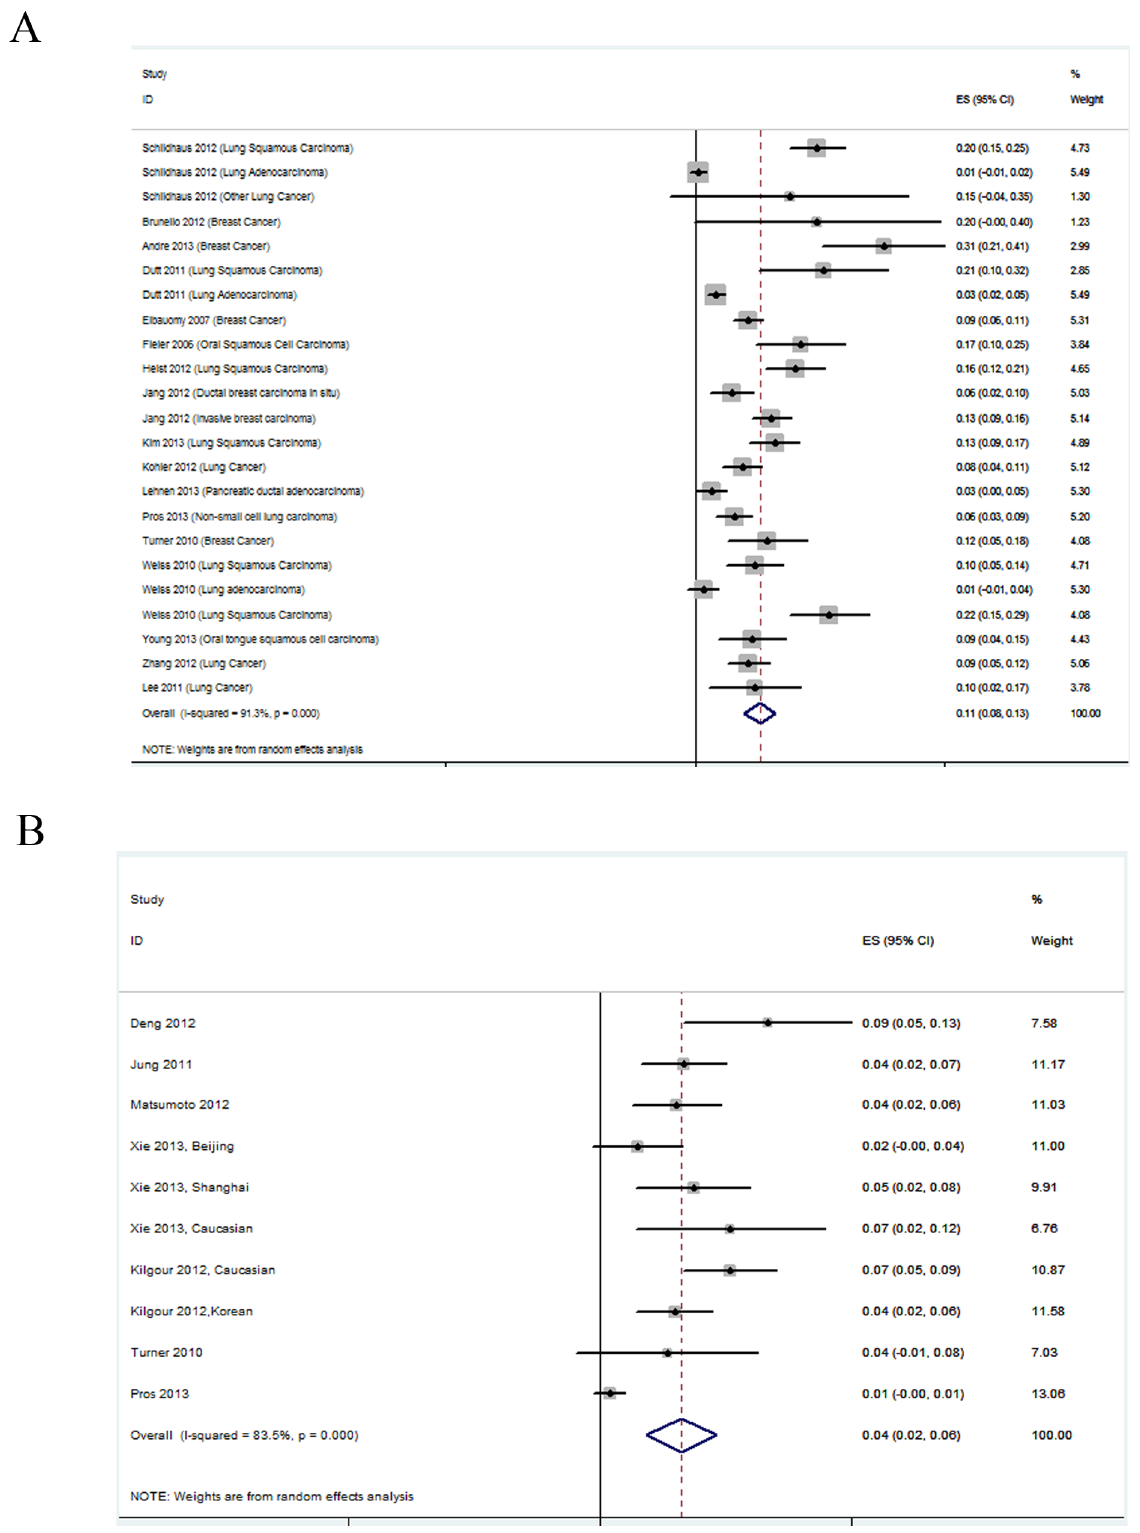
Figure 2. Forest plots describing the prevalence of FGFR amplification. (A) Analysis of the prevalence of FGFR1 amplification. (B) Analysis of the prevalence of FGFR2 amplification. The horizontal lines represent 95% CIs for estimating prevalence of FGFR gene amplification.( & ) Overall estimates of the effects.CI, confidence interval; ES, estimation.